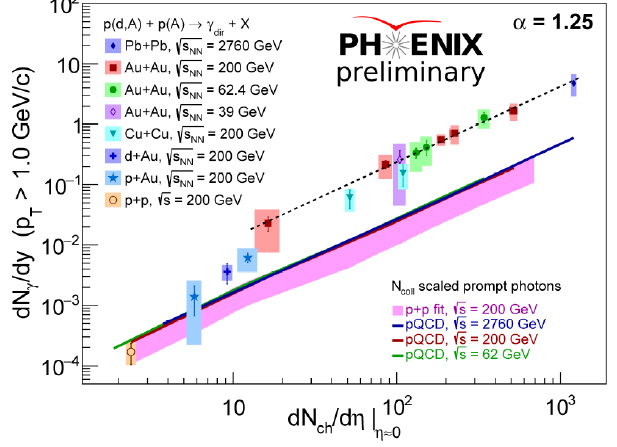
Figure 3. Direct photon yields integrated at p T > 1 GeV/c shown as a function of charged particle multiplicity at midrapidity dN ch /d  | 